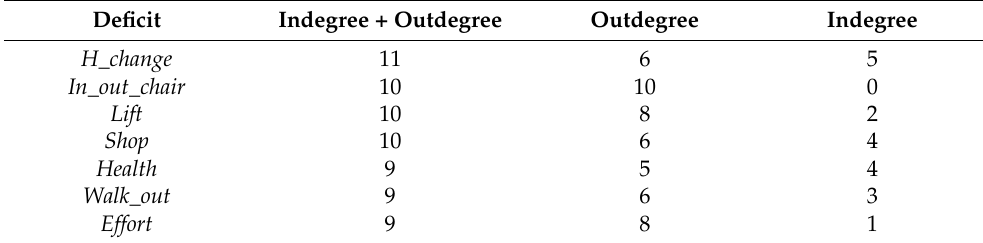
Table 2. Indegree, outdegree, and sum of both measures for the averaged Bayesian network associated with frailty components and dead.